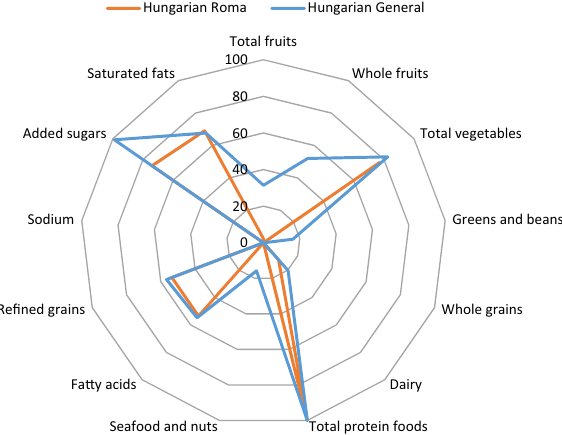
Figure 1. Radar plot of average Healthy Eating Index-2015 component scores for Hungarian Roma and general samples * . * A radar plot displays information about each component score simultaneously. The outer edge of the “wheel” represents a score that is 100% of the maximum score for that component, while the centre of the circle represents a score of 0% of the score for any component.